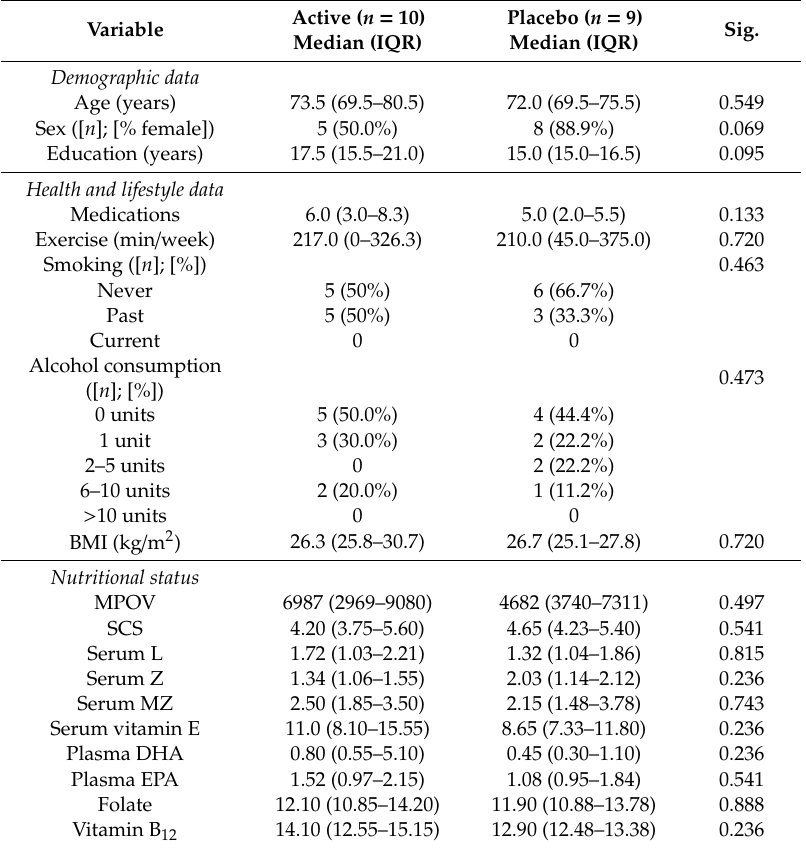
Table 2. Baseline demographic, health and lifestyle data of active and placebo intervention